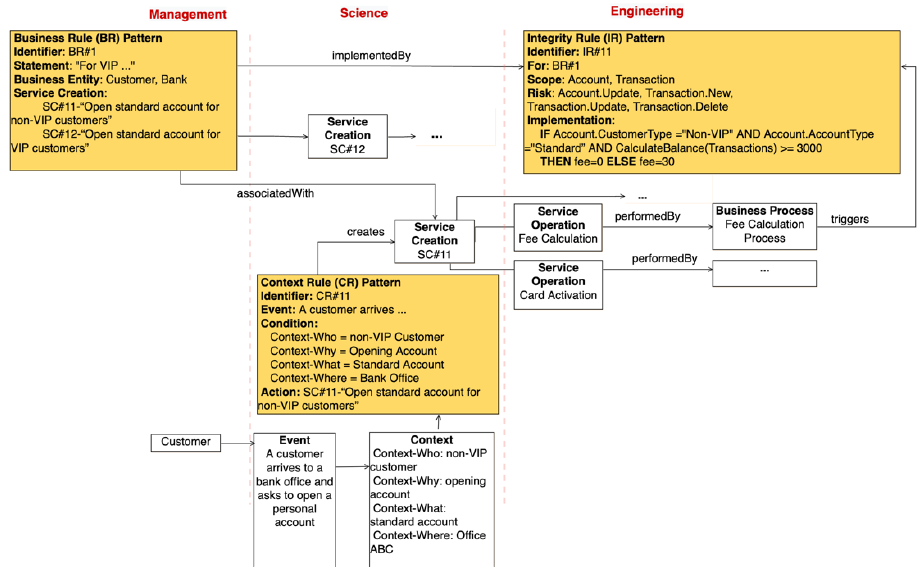
Fig. 4. Example of RuCBS patterns for describing Scenario#1